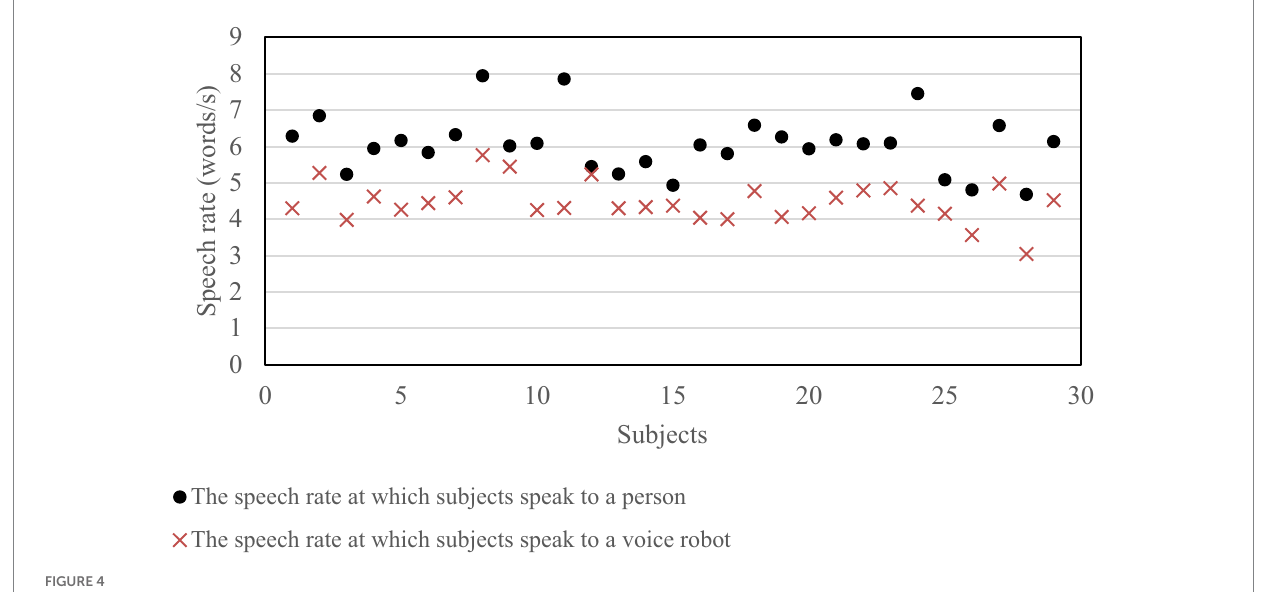
FIGURE 4 Distribution of subjects’ speech rate.